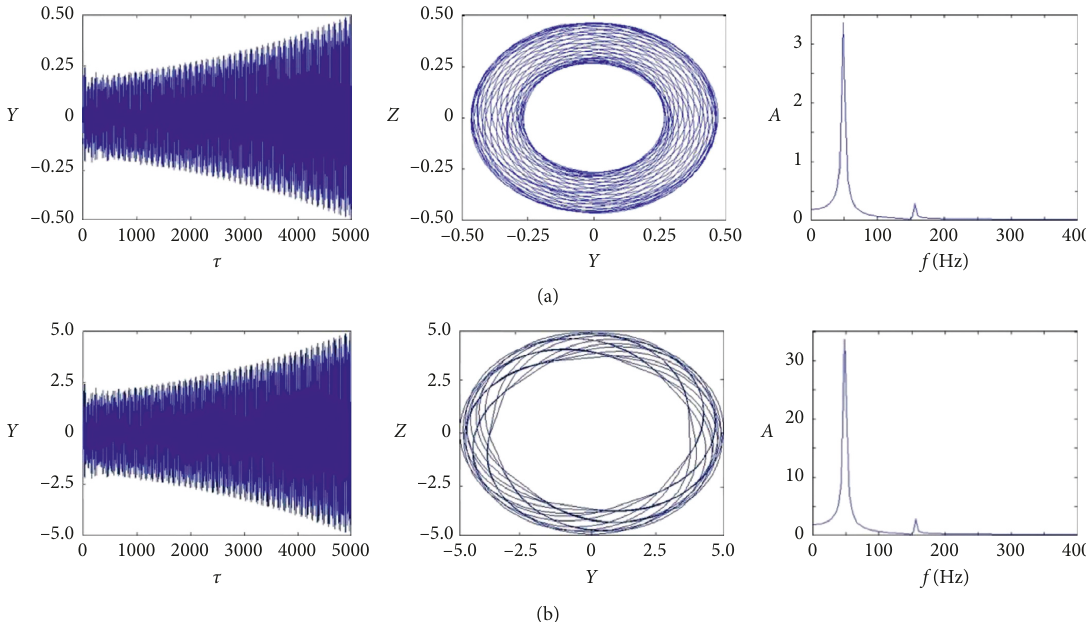
Figure 9: Rotor responses of the time domain, axis orbit, and spectrum at eccentric distances e speed 800 rad/s. (cid:29) Ω